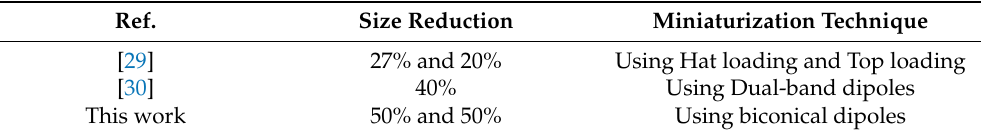
Table 4. Comparison between the miniaturization techniques used in [29,30] and the proposed work.